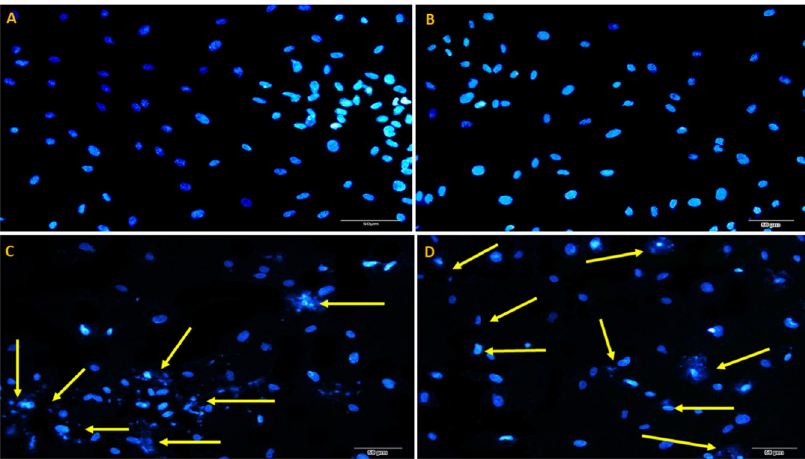
Fig. 6 The results of DAPI staining in A rBMSCs and B rATSCs represented normal healthy chromatin. C TiO 2 - treated rBMSCs, D TiO 2 -treated rATSCs. The yellow arrows show condensed or destroyed chromatin in groups C and D cells